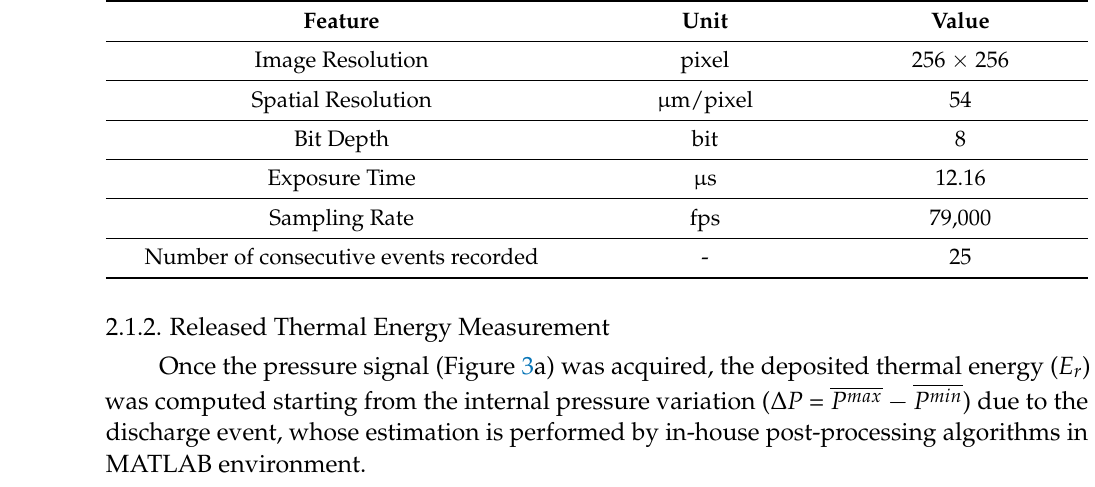
Table 1. High-speed camera settings.